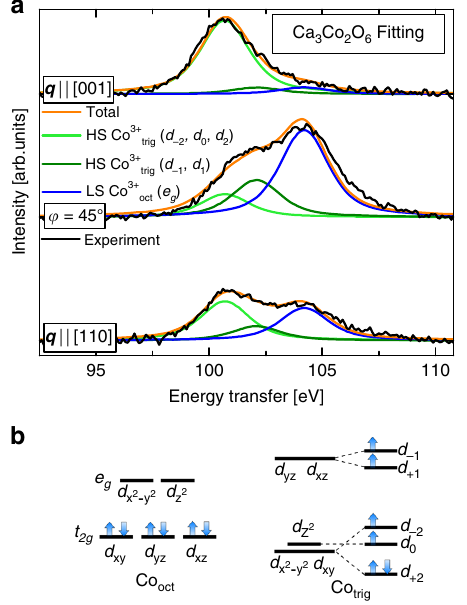
Fig. 4 Voigt function fi tting of experimental NIXS spectra. a The experimental spectra (black) were fi t with Voigt functions that are a convolution between a 1.4 eV FWHM Gaussian function (to model the experimental resolution) and a 1.8 eV FWHM Lorentzian function (to model lifetime broadening). The component curves were integrated for each spectrum of Fig. 3, and this value is plotted on the polar plot of Fig. 5, as a function of sample angle. b A schematic energy level diagram for the Co oct site in a 3 + low-spin state shows that all the holes are in the e g orbitals, while the energy level diagram for the Co trig site shows the energy levels determined in this experiment. We observe that the Co is in a 3 + high-spin con fi guration, and that the sixth and minority-spin electron occupies the d 2 orbital in the ground